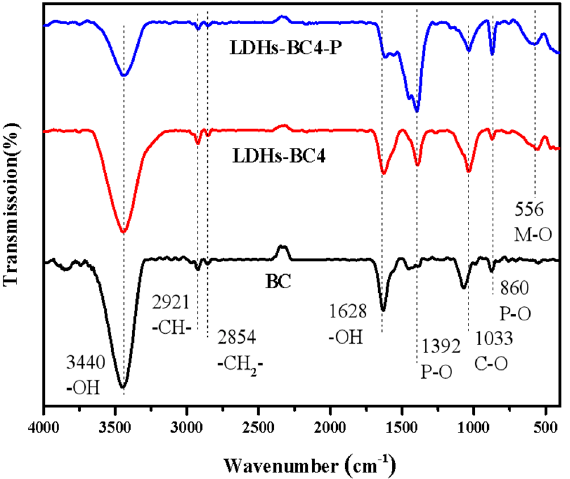
Figure 4. FT-IR spectra of BC, LDHs-BC4, and LDHs-BC4 after phosphate